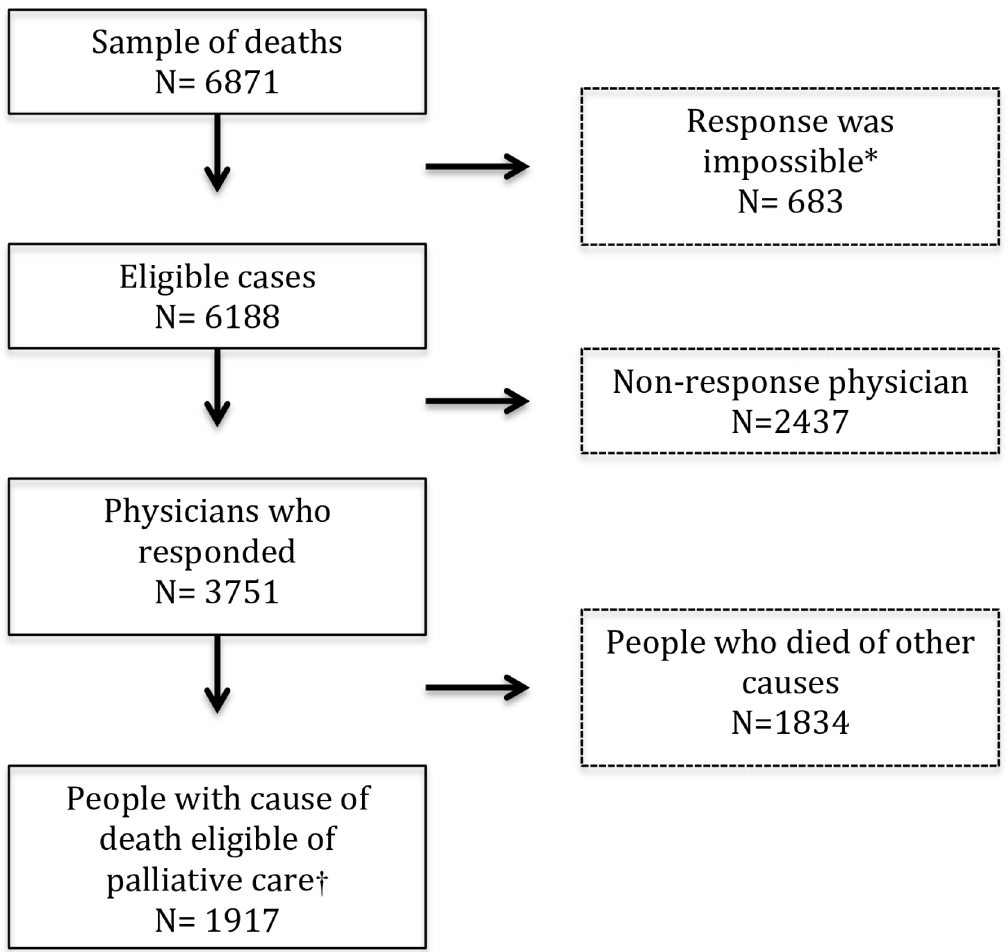
Fig 1. Flow chart of inclusion of deaths and response of physicians. * These cases were deleted from the sample because it was not possible to survey the case. The physician could not identify the decedent with the provided information, no longer had access to the medical file, was not treating physician and did not know who that was, or never received the questionnaire). † For this study we selected a population comprising deaths from underlying causes that, as identified through mixed-methods research based on Rosenwax et al [13] can be considered as indicative of a need for a palliative care approach. The following underlying causes of death were selected: cancer, organ failure, dementia and other illnesses, ie Parkinson ’ s disease, motor neurone disease, HIV/ aids and non-cancerous